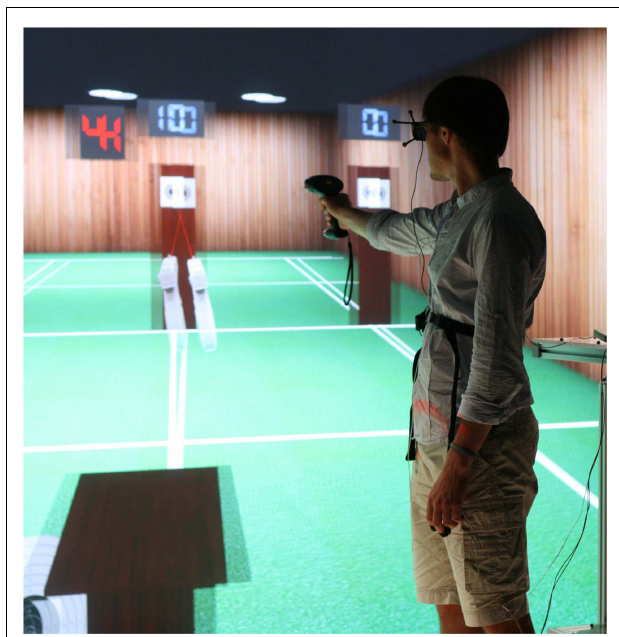
FIGURE 4 | Participant during the pilot experiment .The stand beside the user was needed due to the wired measurement system.The stand has a minimum interference with the projected virtual